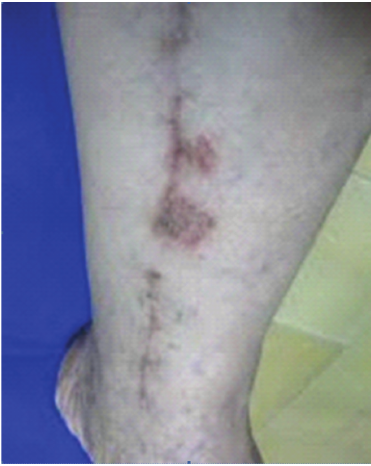
Figure 1: An erythematous discoid scaly patch lateral to the incision scar on the left leg.